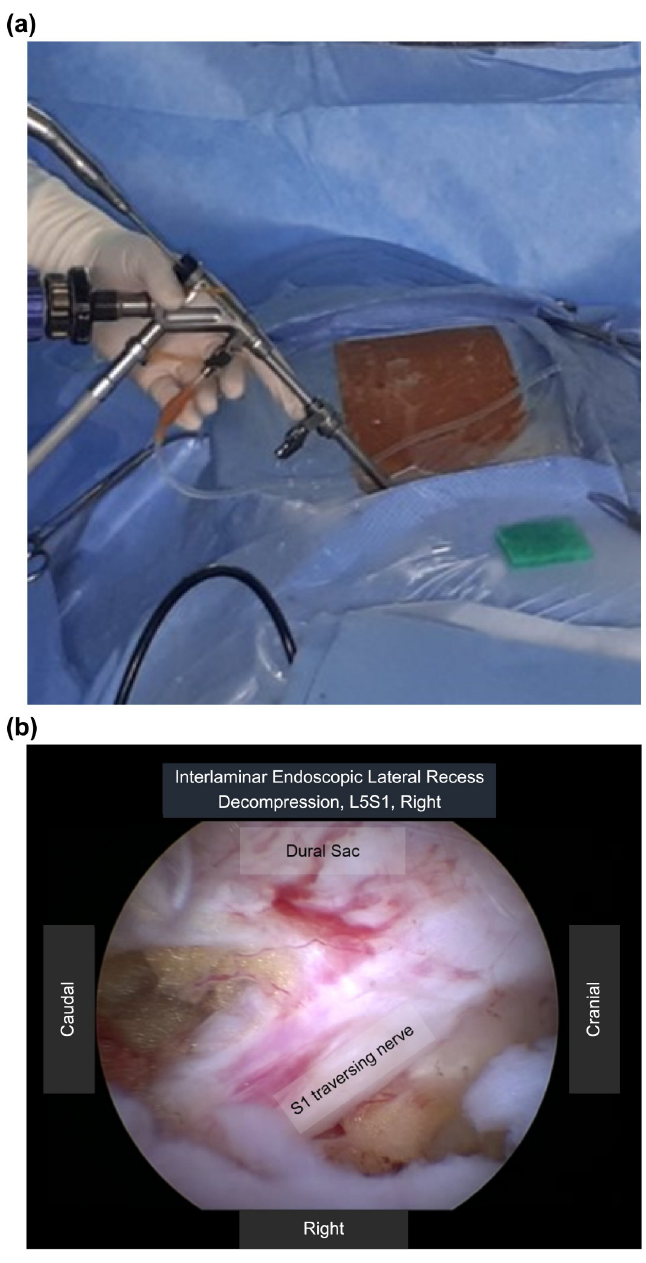
Fig 3. Interlaminar full-endoscopic discectomy. (a) The operative field of the interlaminar full-endoscopic laminectomy procedure is shown. (b) The intraoperative endoscopic view shows the laminectomy site, the decompressed thecal sac, and an individual